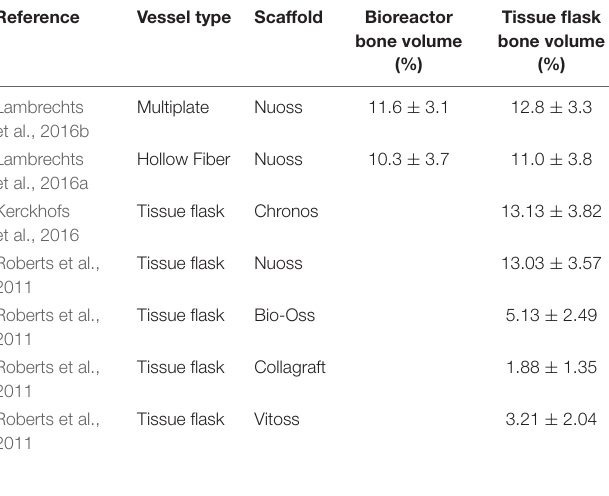
TABLE 6 | Bone percentages after ectopic implantation of hPDCs on scaffolds in mice for 8 weeks. Data gathered from literature.